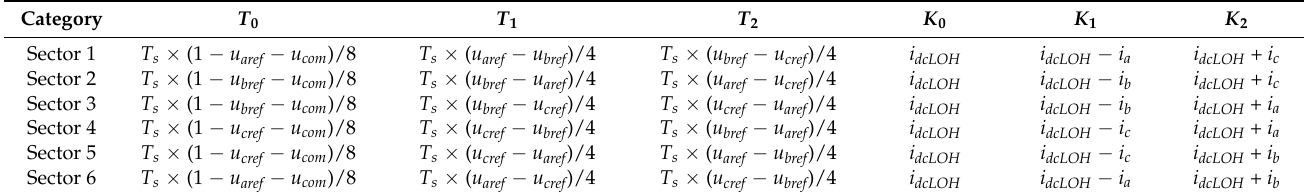
Table 1. The values of K 0 , K 1 , K 2 , T 0 , T 1 , and T 2 in different sectors with SVPWM.